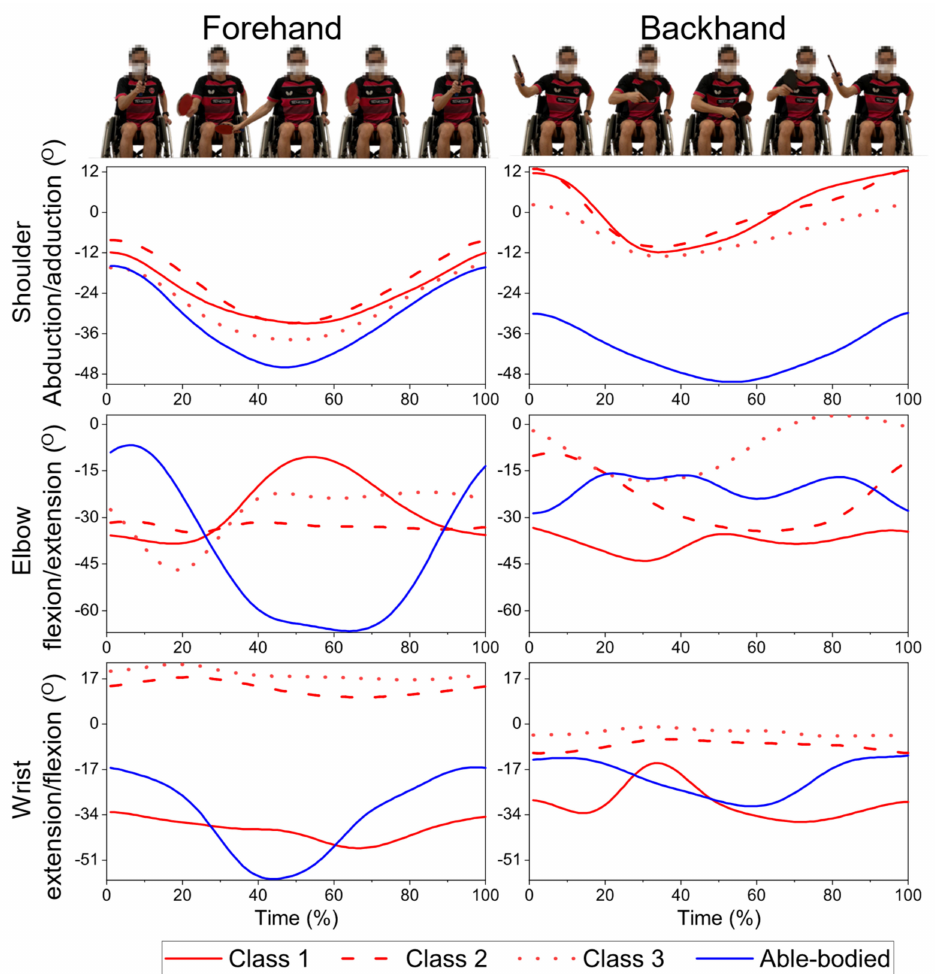
Figure 4. Shoulder, elbow, and wrist joint angle-time histories among classifications 1 ( n = 3), 2 ( n = 3), 3 ( n = 4), and able-bodied ( n = 9) participants while performing the forehand topspin drives ( left ) and backhand topspin drives ( right ). A positive and increasing angle indicates shoulder adduction, elbow extension, and wrist flexion, while a negative and decreasing angle indicates shoulder abduction, elbow flexion, and wrist